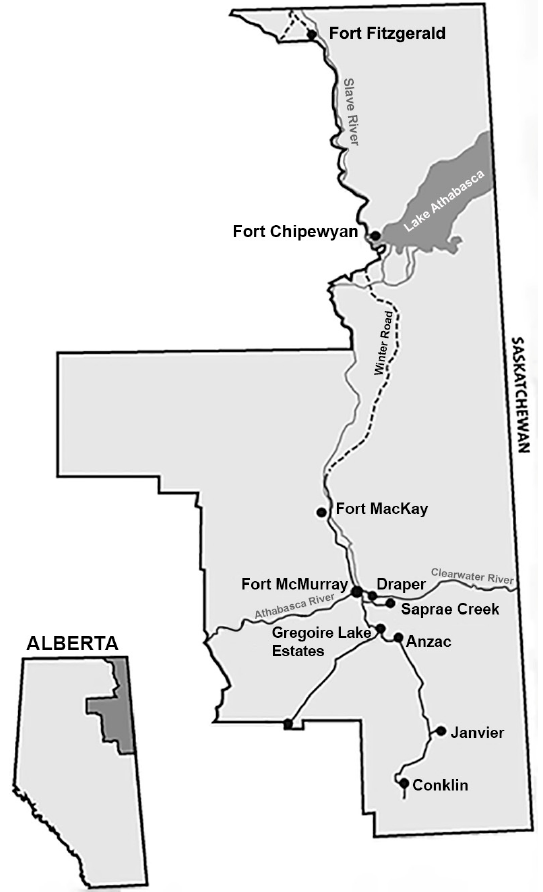
Figure 1. Location of the Regional Municipality of Wood Buffalo, Alberta. Source: Regional Municipality of Wood Buffalo